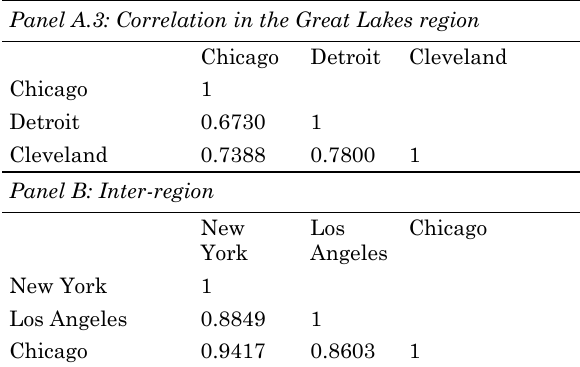
Panel A.3: Correlation in the Great Lakes